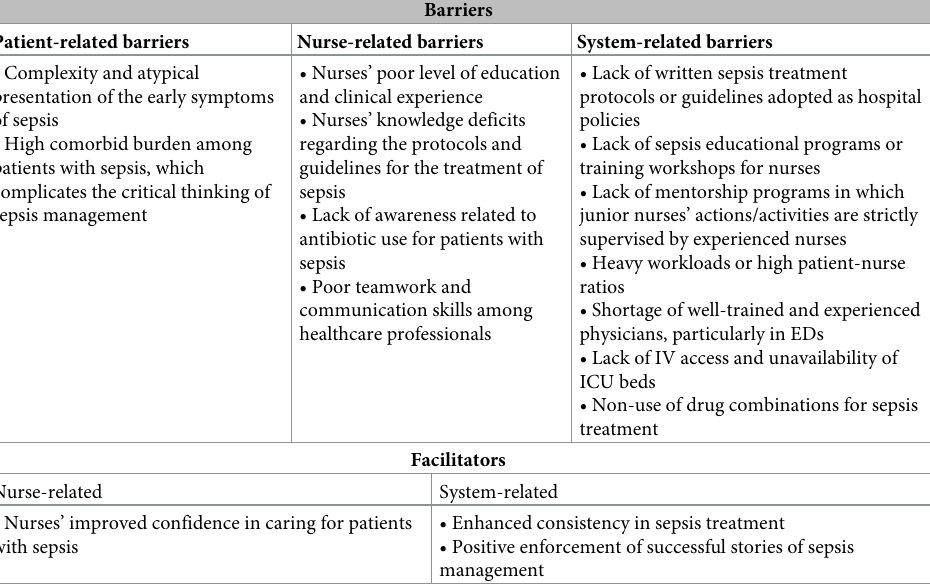
Table 4. The barriers to and facilitators of sepsis assessment and